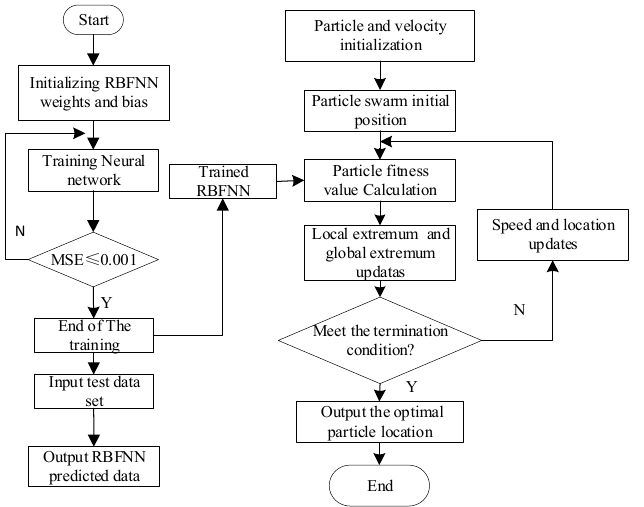
Figure 3. Flow chart of RBF neural-network-improved PSO hybrid adaptive penalty function.